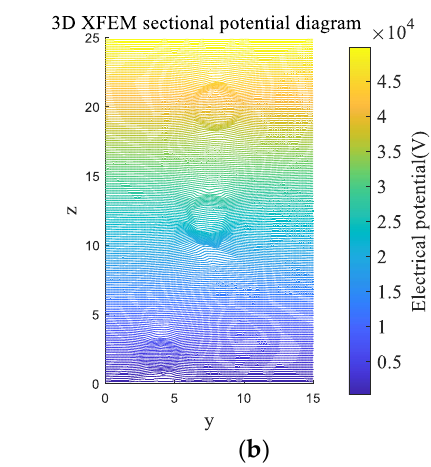
Figure 10. ( a ) 10 bubbles potential diagram at y = 10 mm; ( b ) 10 bubbles potential diagram at x = 7.5 mm.